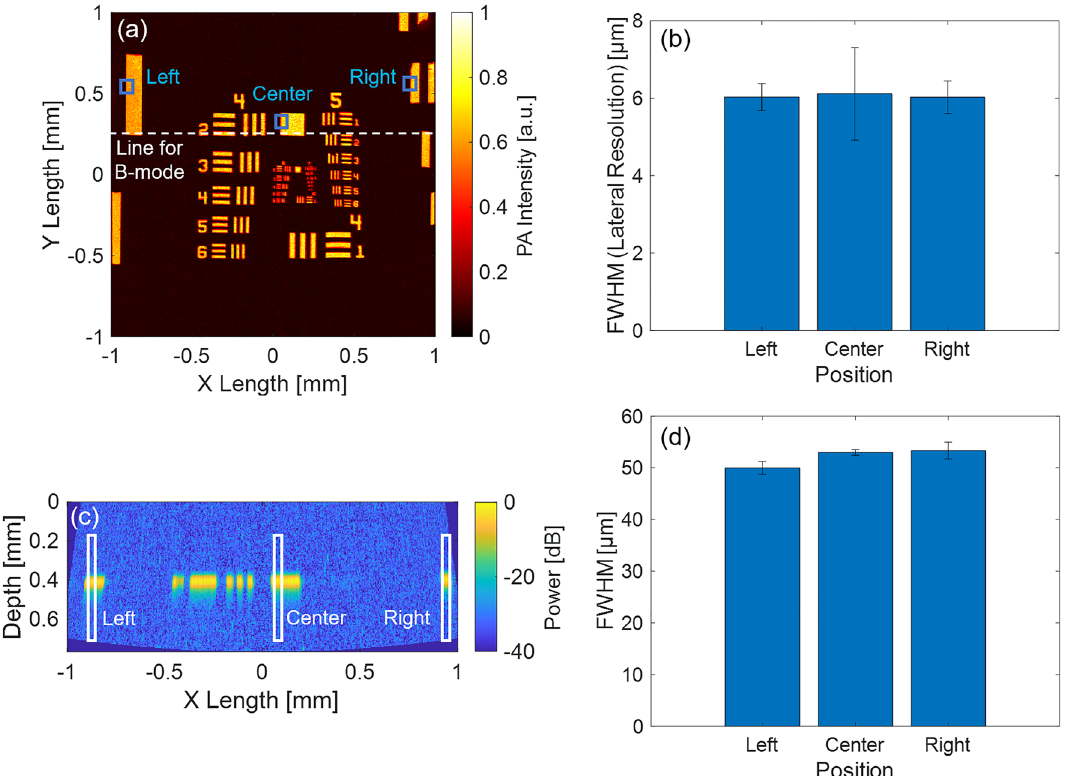
Figure 10. Investigation of the spatial variation of lateral/axial resolution using USAF1951 target. ( a ) C-mode image (nonlinear distortion correction, X × Y = 2 × 2 mm with 800 × 800 points, 10 kHz PRF). ( b ) Lateral resolutions in the position of left/center/right of ( a ). ( c ) B-mode image (nonlinear distortion correction). ( d ) FWHMs of the intensity profiles in the position of left/center/right of ( c